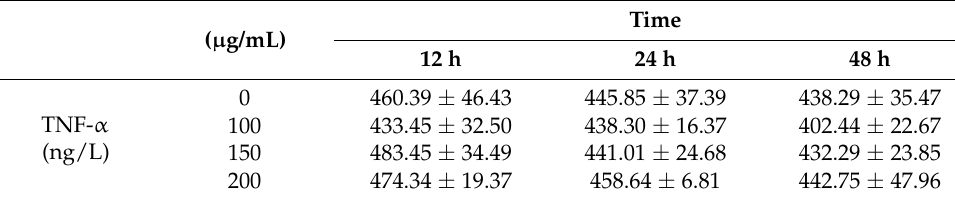
Table 10. Effect of different concentrations of GSP on TNF- α levels in mature